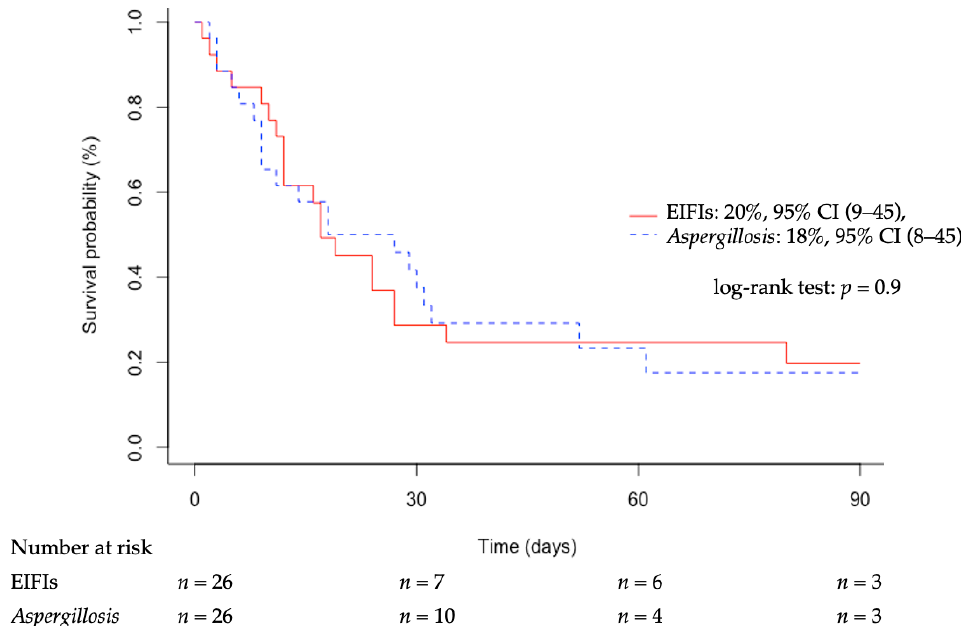
Figure 2. Kaplan–Meier curve of day-90 survival after ICU admission of 26 patients with emerging invasive fungal infec- tions (red line) and 26 patients with aspergillosis (blue dashed line). Emerging invasive fungal infections (EIFIs): Mucorales ( n = 13), Saprochaete ( n = 6), Trichosporon ( n = 1), Fusarium ( n = 2), Scedosporium ( n = 2), Chaetomium ( n = 1), Saccharomyces ( n = 1). 95% CI: 95% confidence interval.